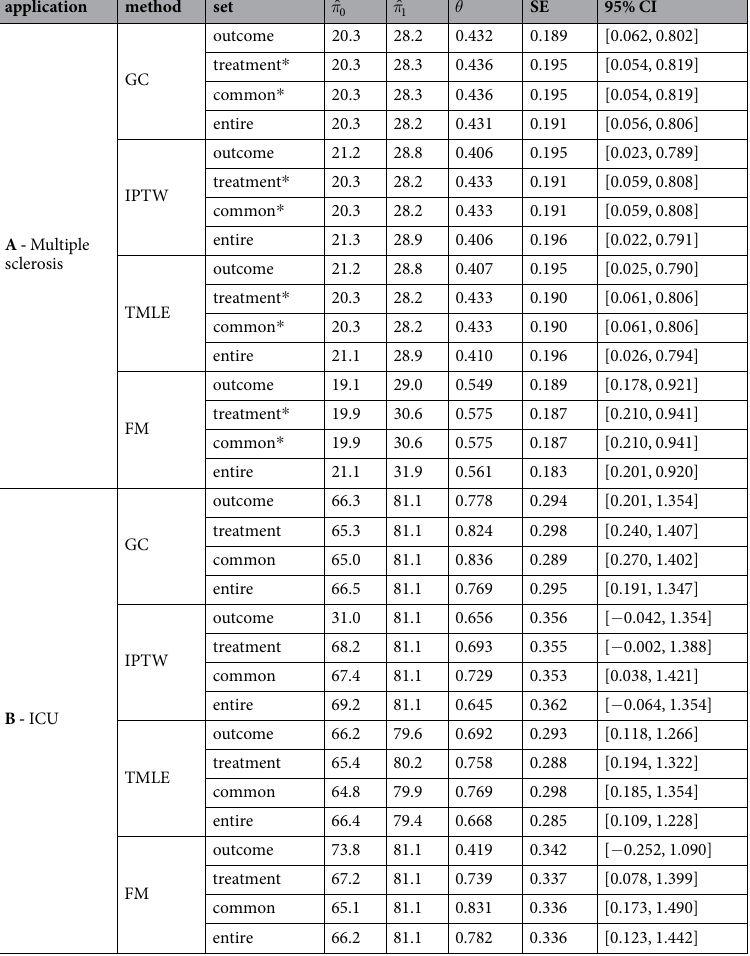
Table 4. Results of the two applications. * Treatment and common sets contain same covariates. π 0 : Percentage of event in the Natalizumab (or control) group, π 1 : Percentage of event in the Fingolimod (or Barbiturates) group, SE: standard